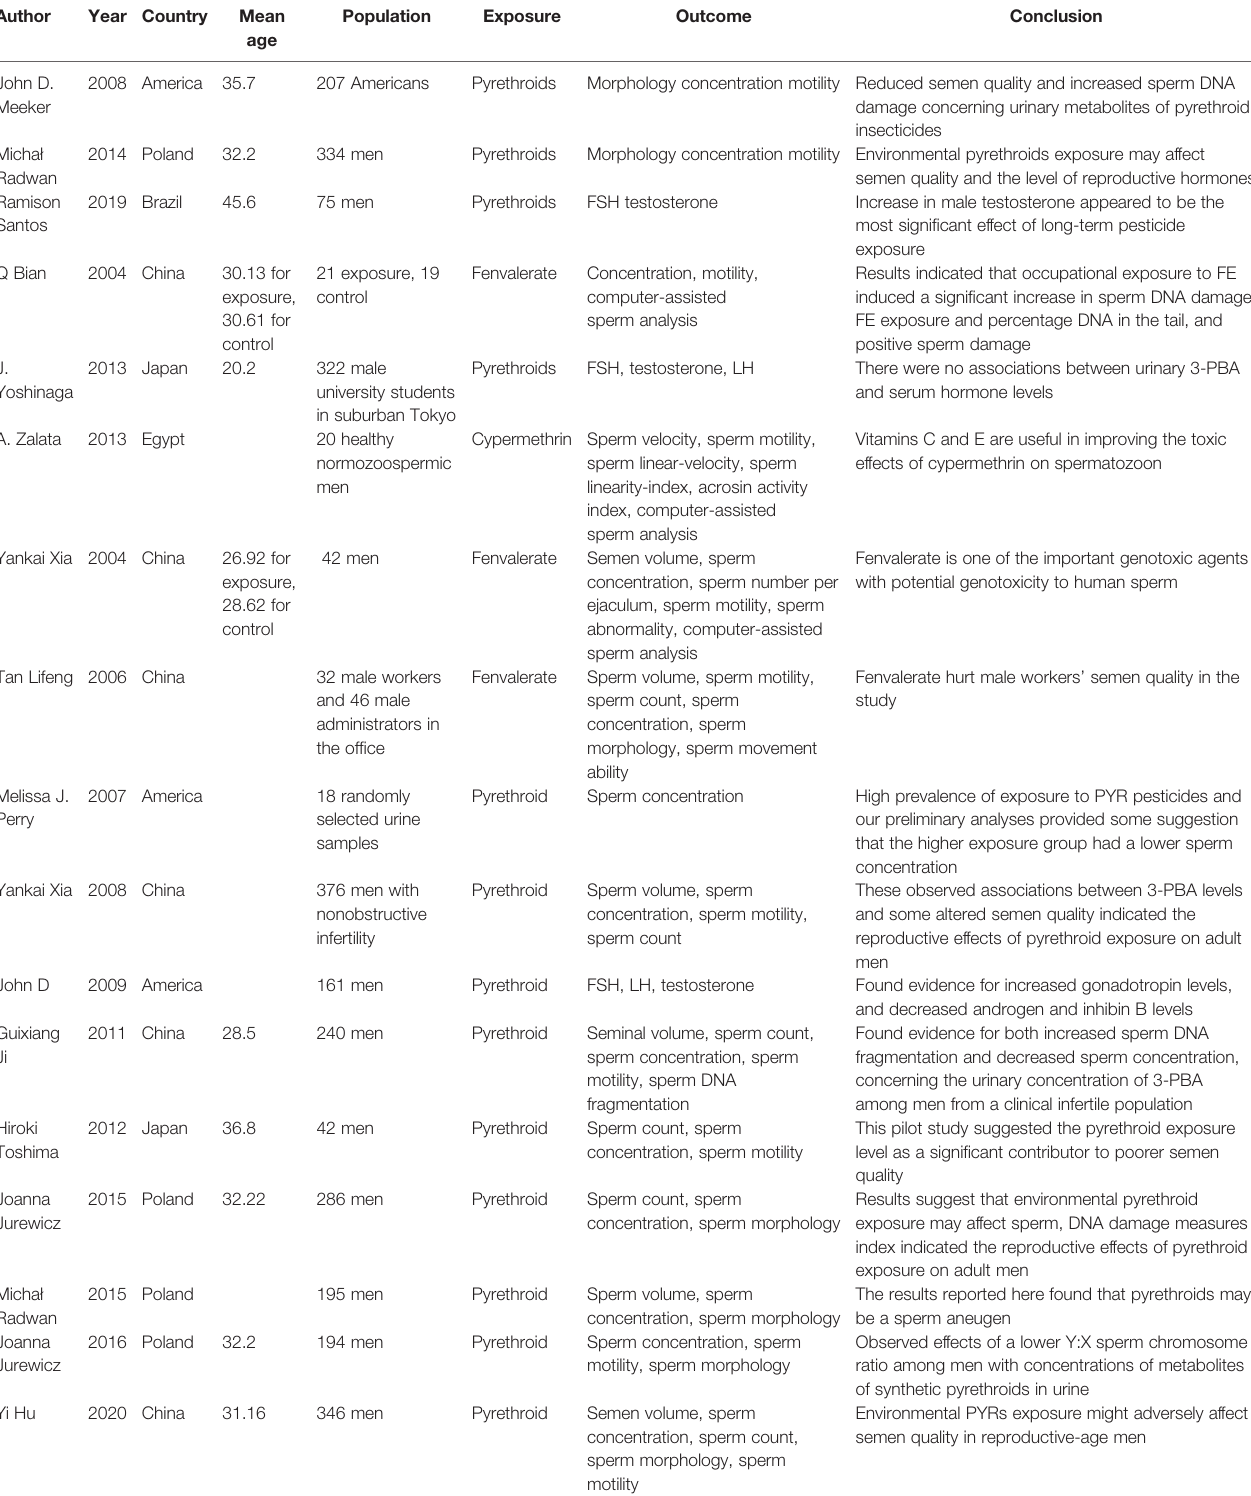
TABLE 3 | Characteristics of included human studies reporting an association between pyrethroid exposure and reproductive